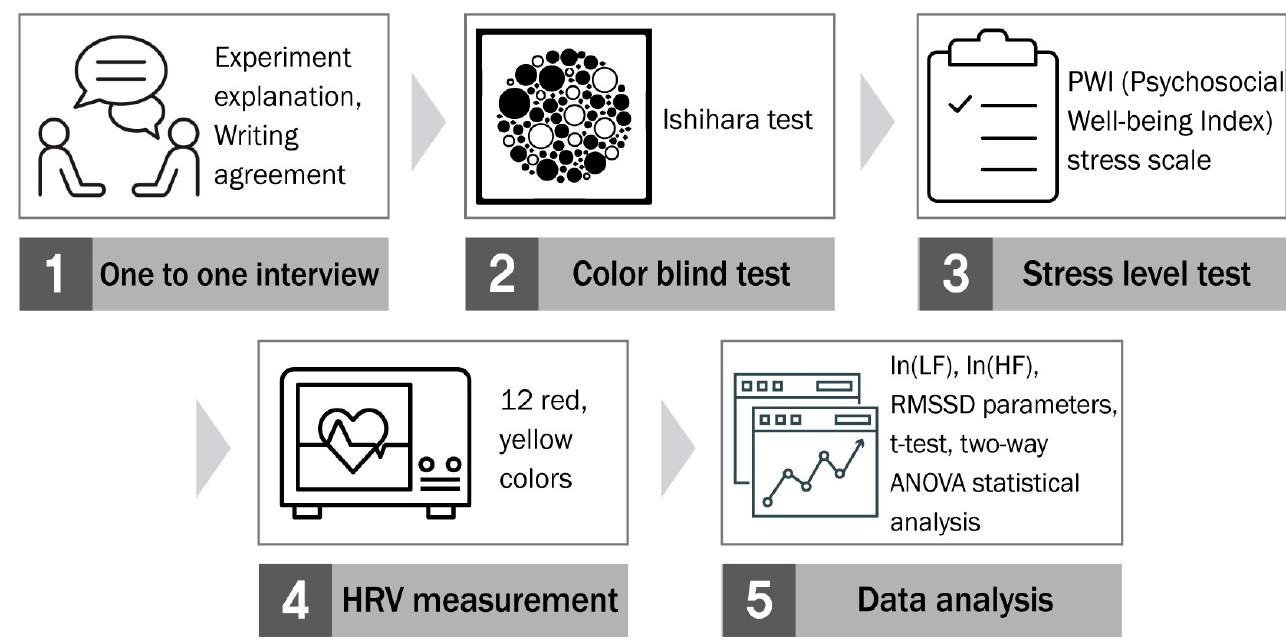
Figure 5. Experimental procedure.